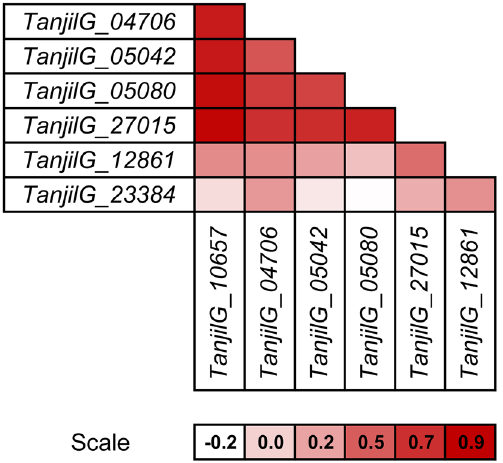
Figure 7. Correlations between gene expression profiles revealed using quantitative PCR. Analyzed narrow- leafed lupin lines were as follows: 83A:476 (resistant, carrying homozygous Lanr1 allele), Mandelup (moderately resistant, carrying homozygous AnMan allele), Boregine (resistant, unknown genetic background), and Population 22660 (susceptible). Calculations were performed for three time points (6, 12, and 24 stand for hours post inoculation) including results obtained for inoculated ( Colletotrichum lupini , strain Col-08, obtained in 1999 from the lupin field in Wierzenica, Poland) and control (mock-inoculated) plants. Scale shows Pearson correlation coefficient